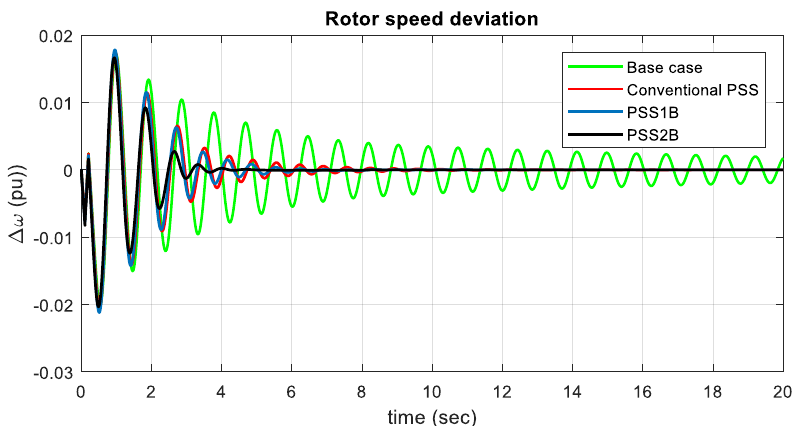
Figure 21. Rotor speed deviation of the power system at light loading.